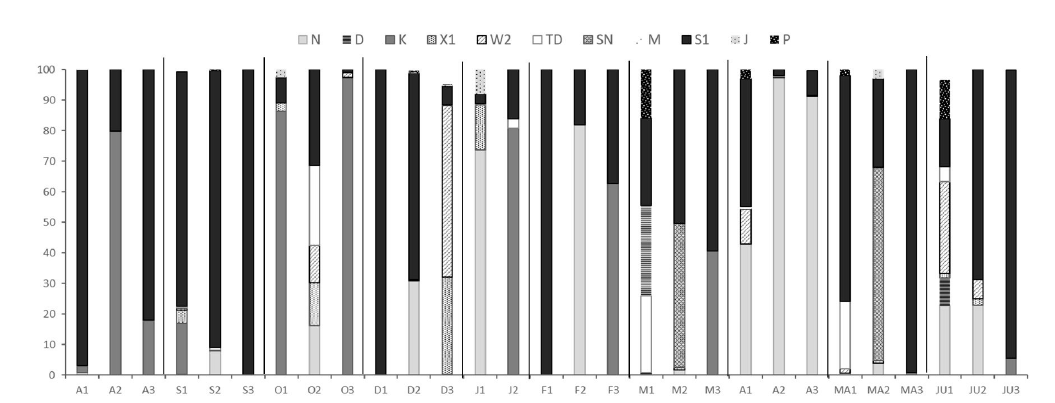
Figure 3. Contributions of those phytoplankton functional groups representing 10% or more of the total biomass in the Santa Lúcia lake from August 2014 to June 2015. Legend: A (August), S (September), O (October), D (December), J (January), F (February), M (March), A (April), MA (May), JU (June), respectively. Numbers 1,2,3: sampling Table 1. Average values for the limnological variables and the macrophytes in the Santa Lúcia Lake (Paraiba, Brazil). Variables